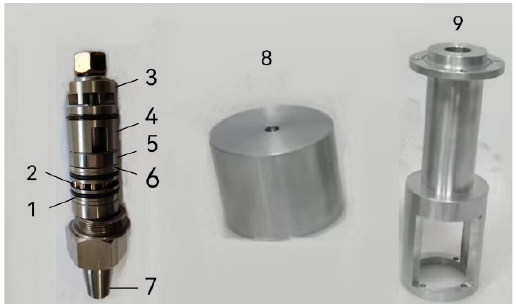
Figure 10. The sealing device in the experiment: 1—pole pieces, 2—permanent magnet, 3—back blade seal, 4—water-stop sheet, 5—bearing, 6—magnetic isolation ring, 7—shaft, 8—sealing chamber, and 9—shell.